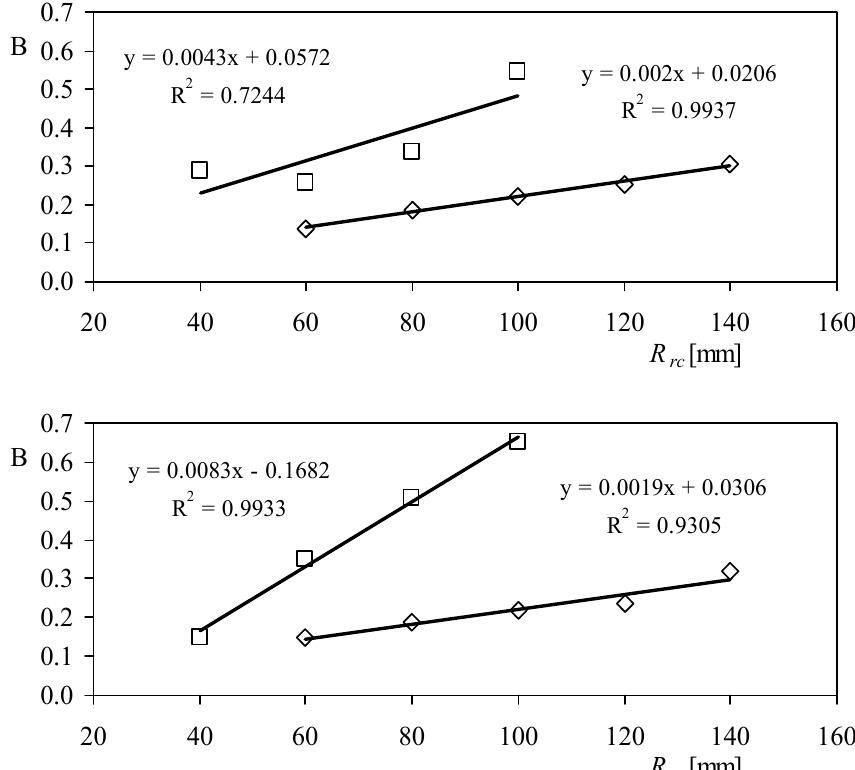
Figure 11. Calibration coefficients, B, as a function of the cups’ center rotation radius, , for the Climatronics 100075 ( top ) and the Ornytion 107A ( bottom ) anemometers. R rc Anemometers equipped with 50 mm diameter cups (squares), and 80 mm diameter cups (rhombi).